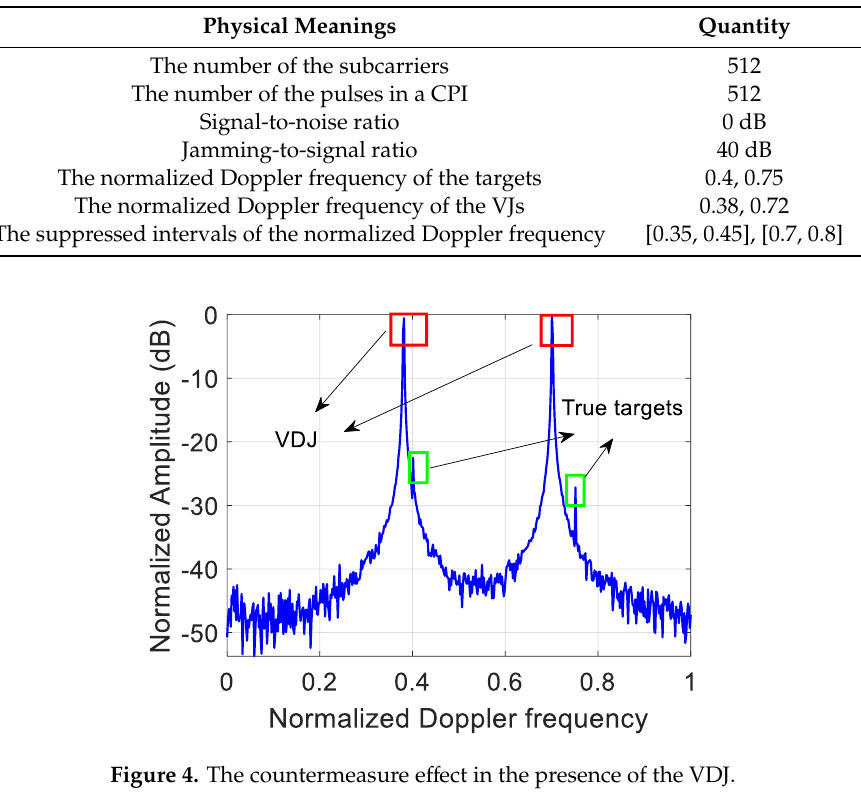
Figure 5. The results of resisting the VDJ using the different methods. ( a ) Comparison of random phase and POCG. ( b ) Comparison of random phase and POCG.